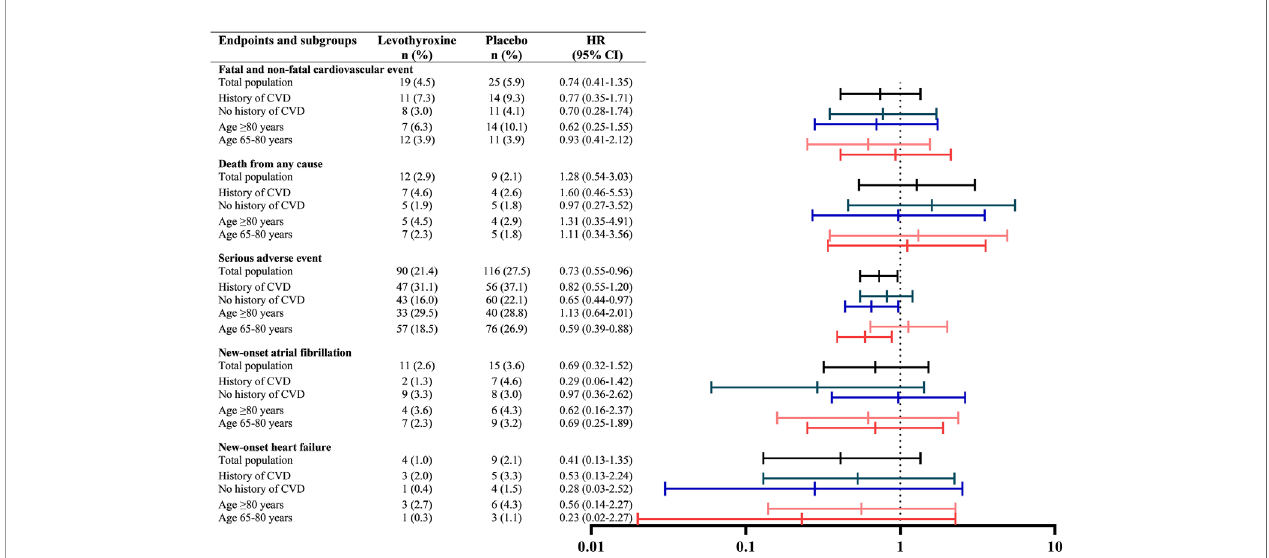
FIGURE 2 | Cardiovascular outcomes strati fi ed for history of cardiovascular disease and age. Cardiovascular disease (CVD) is de fi ned as ischemic heart disease, stroke or transient ischemic attack, heart failure, peripheral vascular disease, revascularisation or atrial fi brillation. Hazard ratios for treatment were obtained from a Cox proportional hazard regression model predicting and were adjusted for study, country, sex and starting dose of